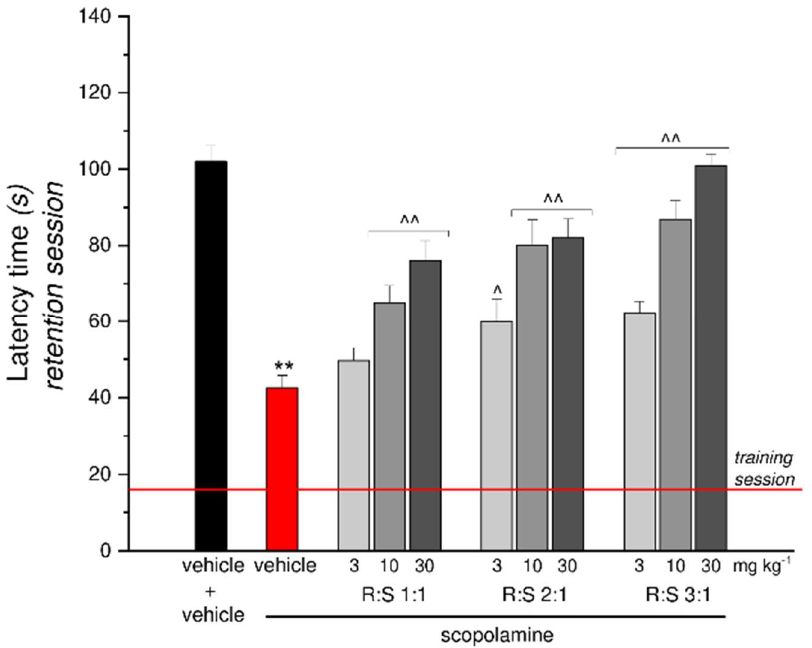
Figure 5. Effect of R:S 1:1, R:S 2:1 and R:S 3:1 against scopolamine-induced amnesia in mice in the Passive avoidance test. The latency (s) to enter the dark chamber during the retention test is reported. The red line represents the latency time for inexperienced mice recorded during the training session. Compounds R:S 1:1, R:S 2:1 and R:S 3:1 at different dosages (3 mg kg −1 , 10 mg kg −1